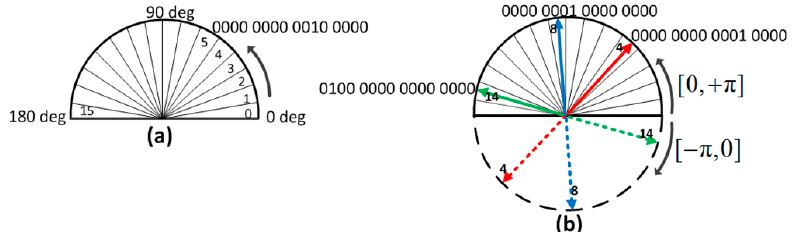
Figure 1. ( a ) A semi-circle is divided into 16 parts which are congruent with each other, and every part has an unique discrete direction; ( b ) The orientation of the gradients and their binary strings.